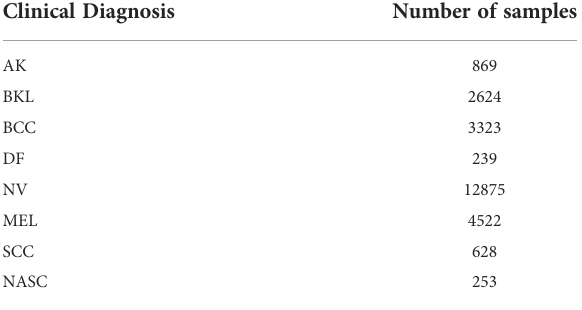
TABLE 2 Distribution of skin disease samples in ISIC 2019 data.